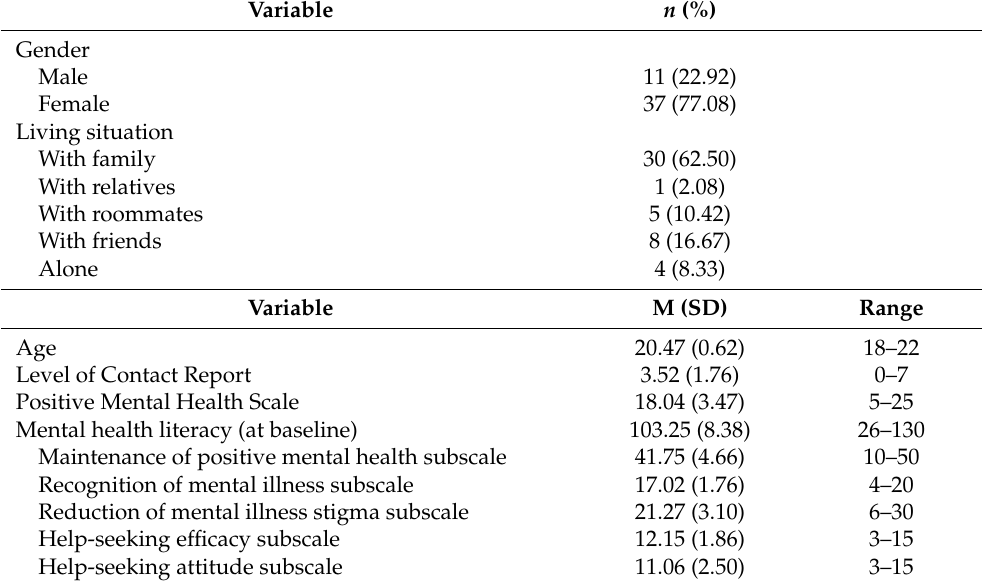
Table 2. Characteristics of the sample ( n =